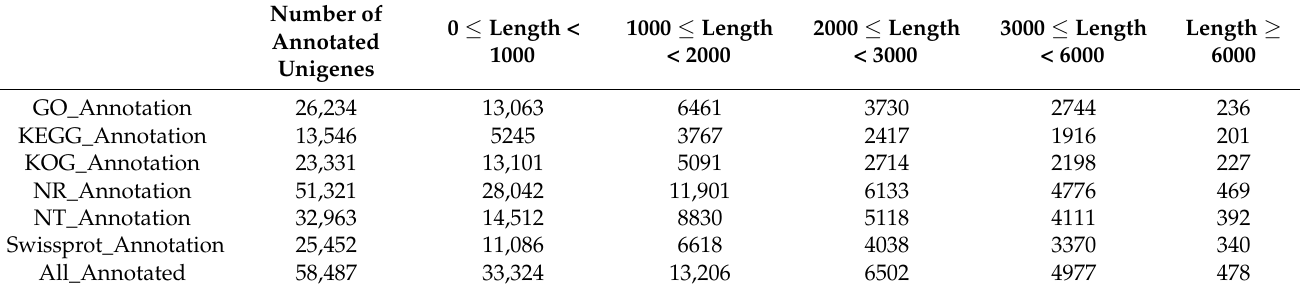
Table 2. Summary of the transcriptome